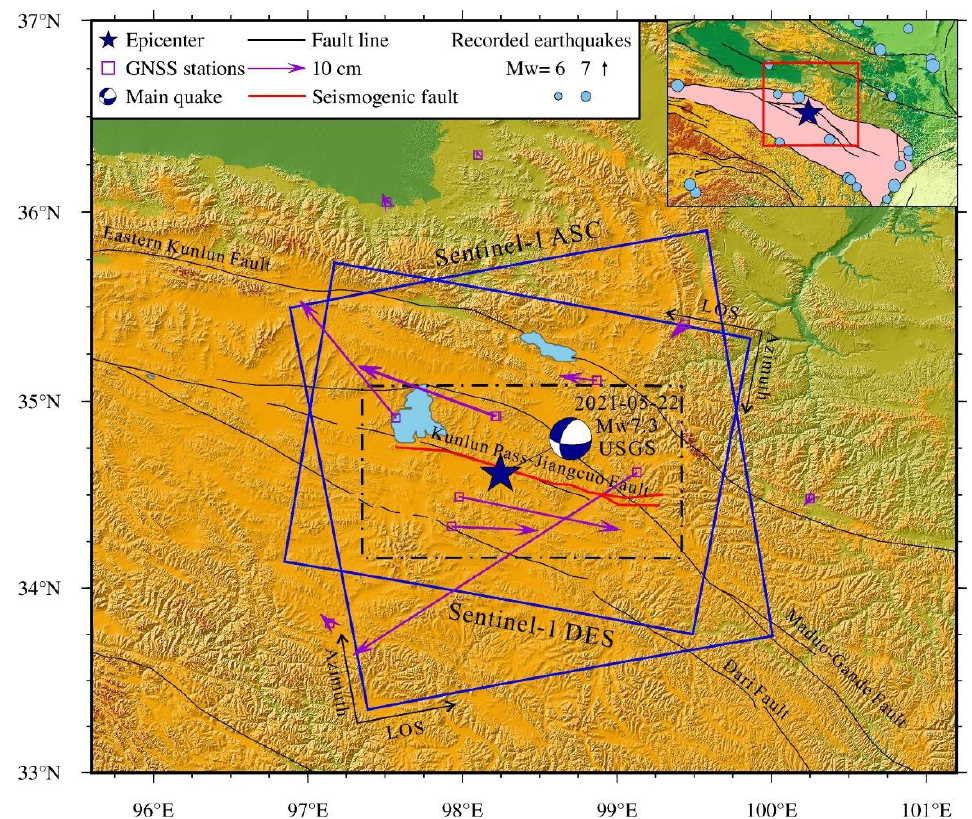
Figure 1. The record of historic earthquakes around the 2021 Maduo earthquake and the ground coverage of Sentinel-1 data used in this study. The blue star denotes the epicenter of the 2021 Maduo earthquake, black lines denote the known fault lines, blue solid rectangles indicate the ground coverage of the used Sentinel-1 TOPS data, violet arrows represent the coseismic horizontal GNSS deformation caused by the Maduo earthquake (as derived from the work of Li et al. (2021) [27]), red lines represent the surface rupture traces. The coverage of black dashed rectangle is the focused study area.